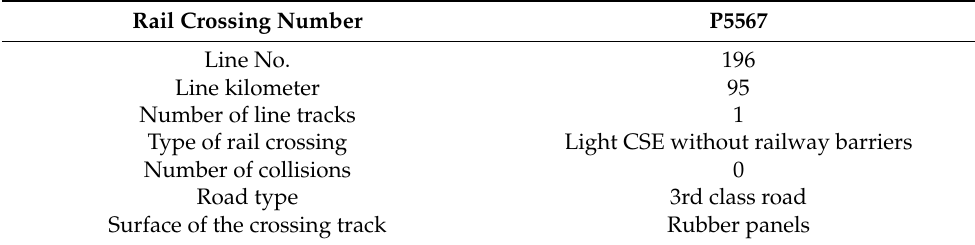
Table 5. Rail Crossing No. P5567–basic figures.